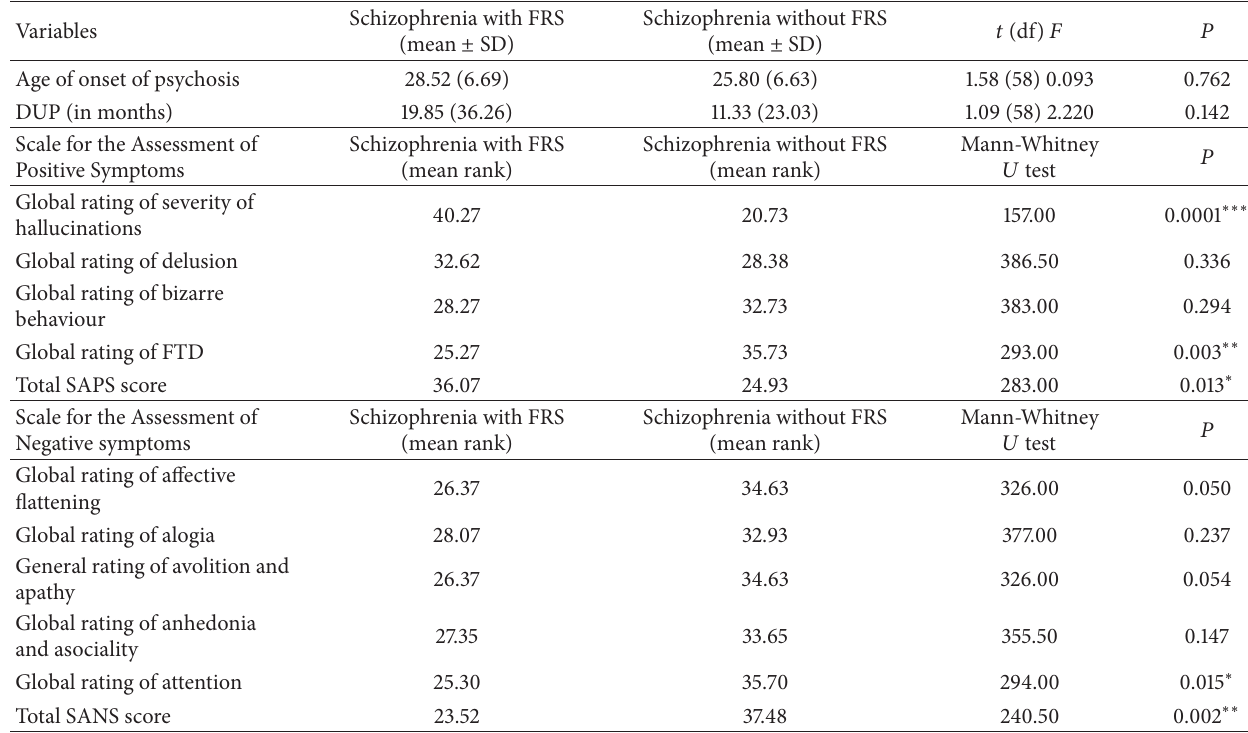
Table 3: Comparison of age of onset of psychosis and duration of untreated psychosis (DUP), Scale for the Assessment of Positive Symptoms (SAPS) scores, and Scale for the Assessment of Negative Symptoms (SANS) scores between schizophrenia patients with and without first rank